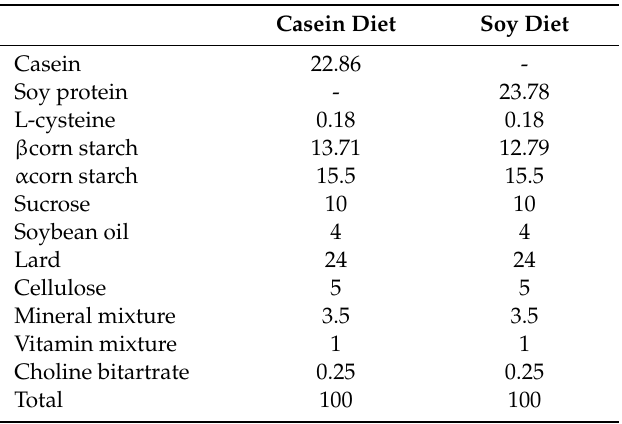
Table 1. Nutrition components (g) in each diet (100